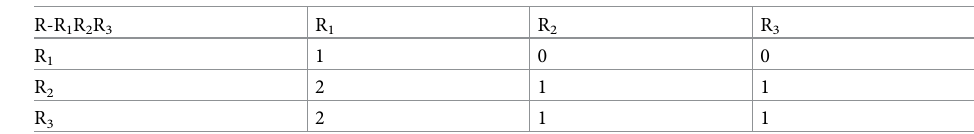
Table 7. Response comparison